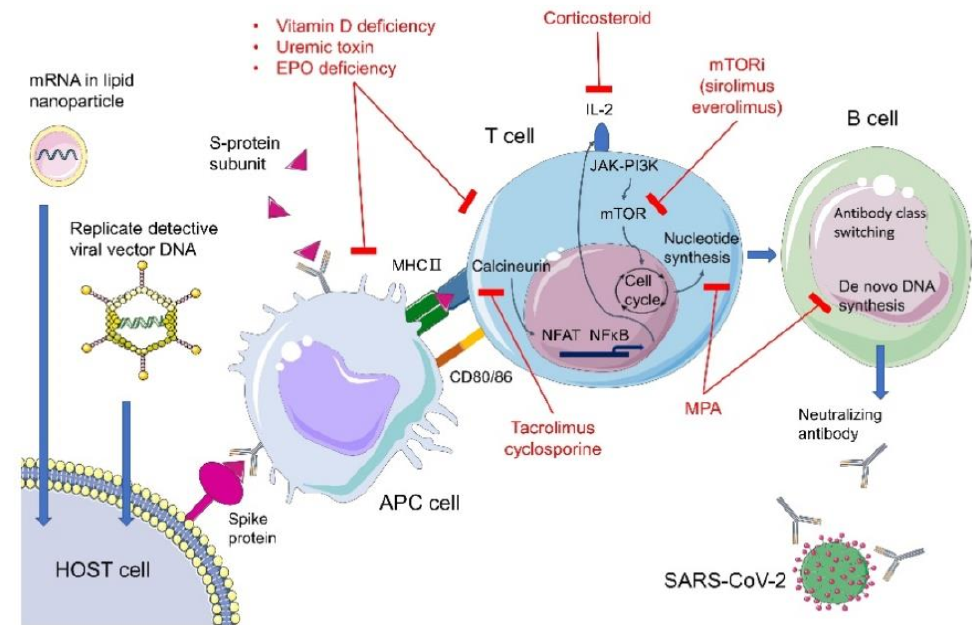
Figure 1. The mechanism of the impaired generation of neutralizing antibody after SARS-CoV-2 vaccine injection in CKD and KT patients. In CKD patients, the vitamin D deficiency, uremic toxin accumulation and erythropoietin deficiency could influence the antigen presenting ability of the antigen presenting cell (APC). In kidney transplantation (KT) patients, the corticosteroid, calcineurin inhibitor (tacrolimus or cyclosporin), mycopheloic acid (MPA) and mechanistic target of rapamycin (mTOR) inhibitor decrease the activity of T cells and the production of neutralizing antibody by B Cells in different aspects.IL2: interleukin 2; JAK-PI3K: Janus-activated kinase/phosphoinositide 3-kinase pathway; MHC: major histocompatibility